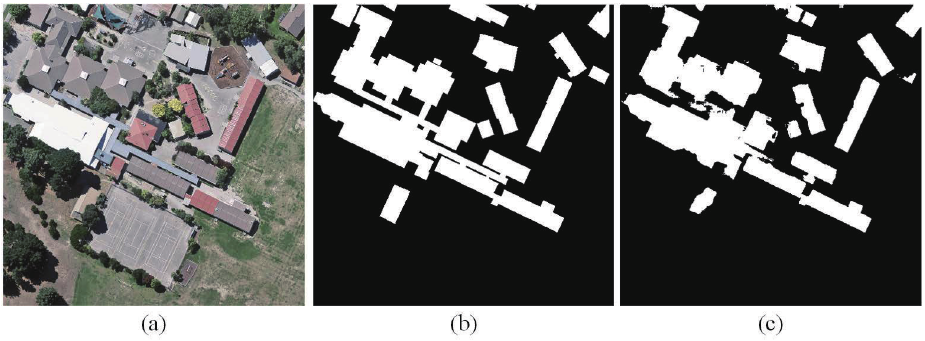
Figure 1. ( a ) The original image, ( b ) the ground truth, and ( c ) the prediction by U-Net [21]. There exist clutters around the boundaries, and some buildings are incomplete. The straight lines and right angles of some buildings are not well